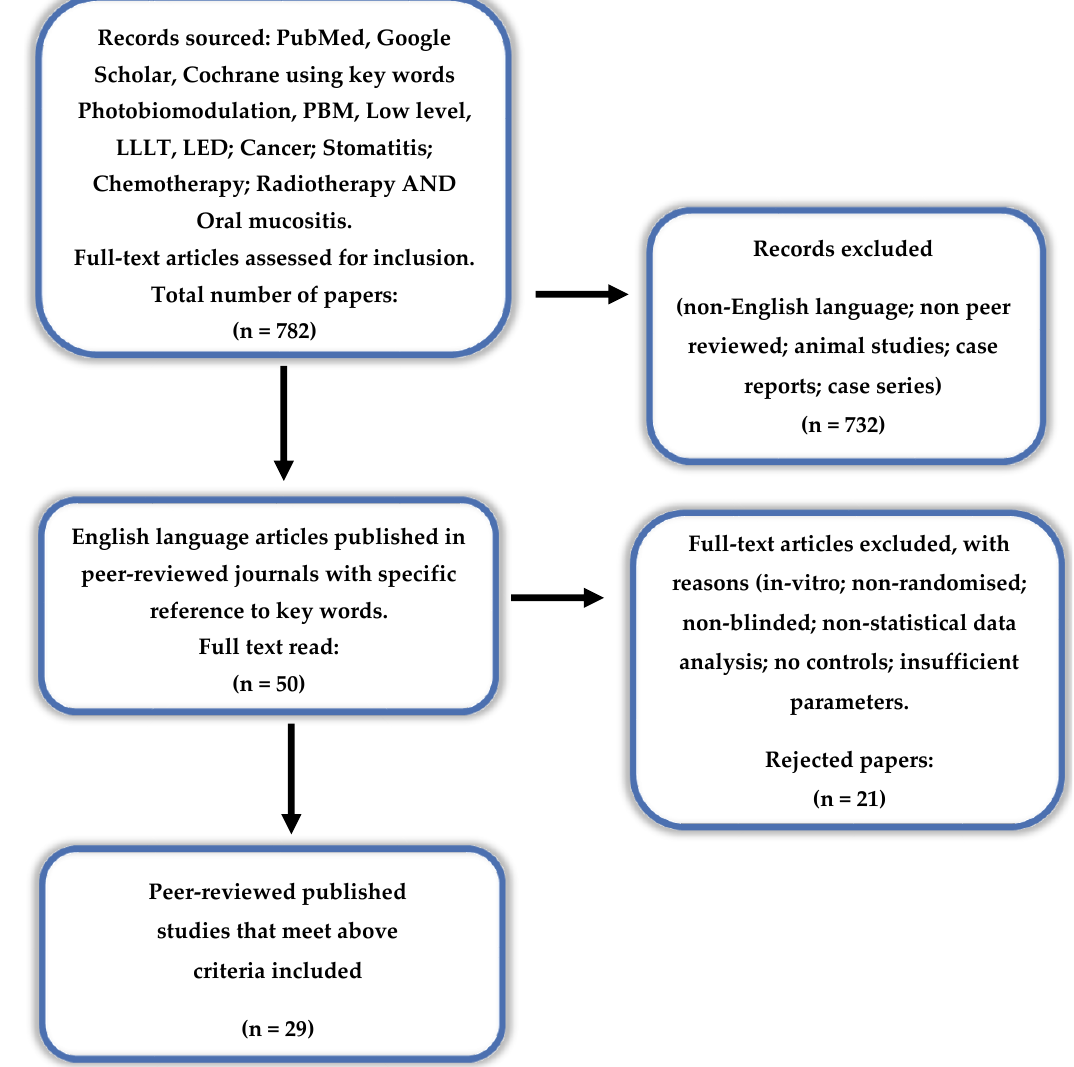
Figure 1. PRISMA flow-chart of selected criteria for the included article reports. (from [22]).